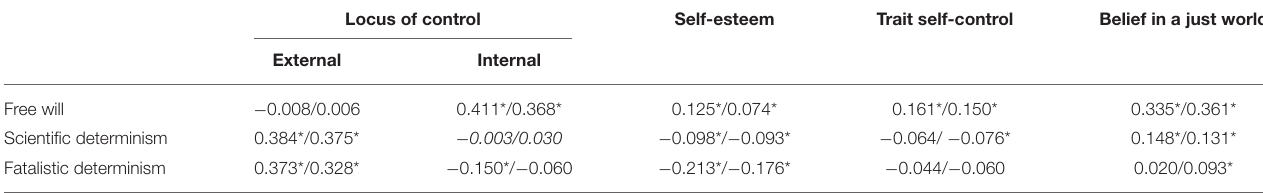
TABLE 7 | Correlation coefficients of subscales of the FAD-Plus and other